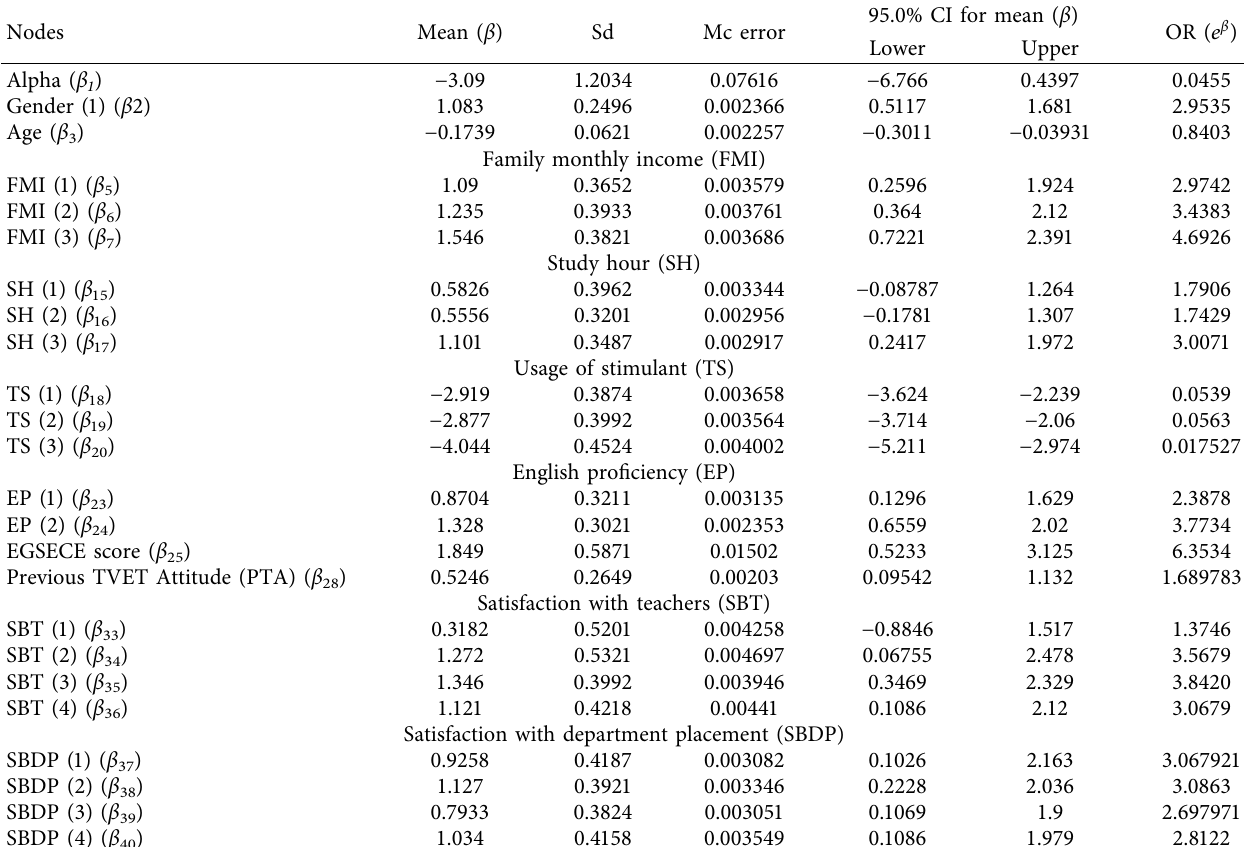
Table 5: Summary statistics for significant covariates in the Bayesian logistic